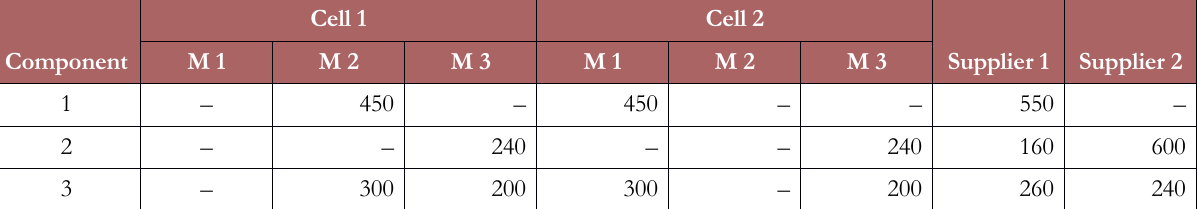
Table 6. First stage optimization results